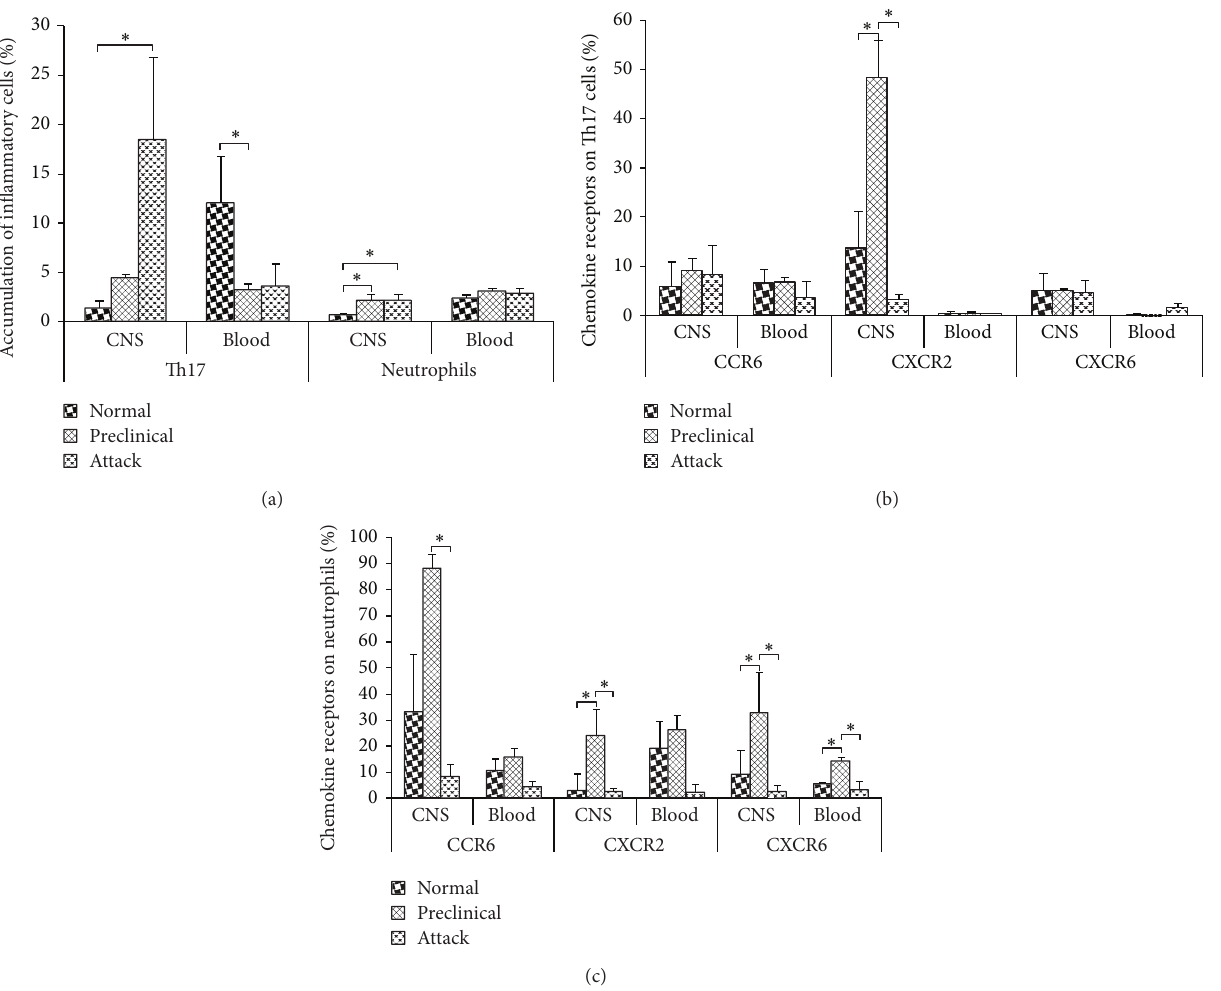
Figure 1: Flow cytometry analysis of chemokine receptors on Th17 cells and neutrophils from the CNS and blood of EAE mice. (a) Percentage of Th17 cell and neutrophils, (b) chemokine receptor expression on Th17 cells, and (c) chemokine receptor expression on neutrophils. Normal—healthy control mice, preclinical—immunized mice before disease onset, attack—second day of EAE symptoms. Data are presented as mean ± SEM. ∗ 0.05 ≥ 𝑃 ≥ 0.01